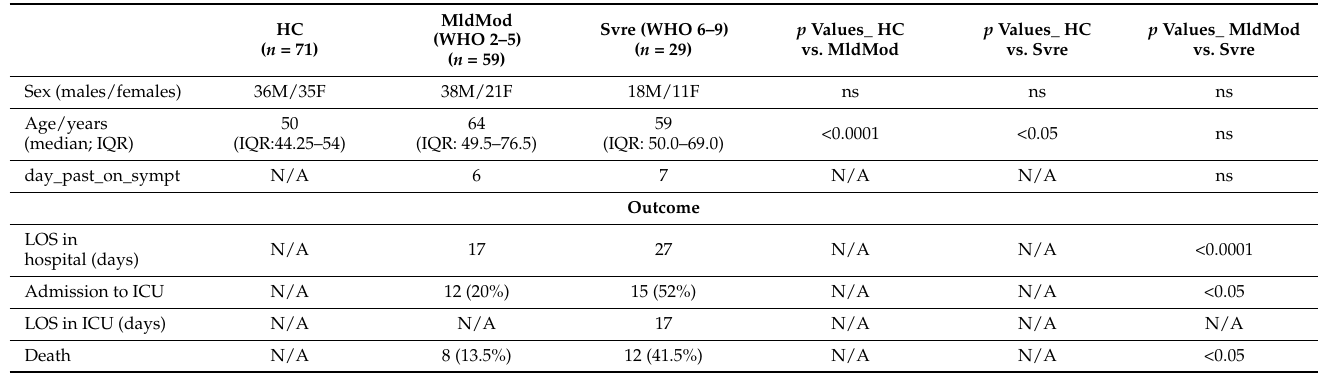
Table 1. Demographic and clinical characteristics of participants.